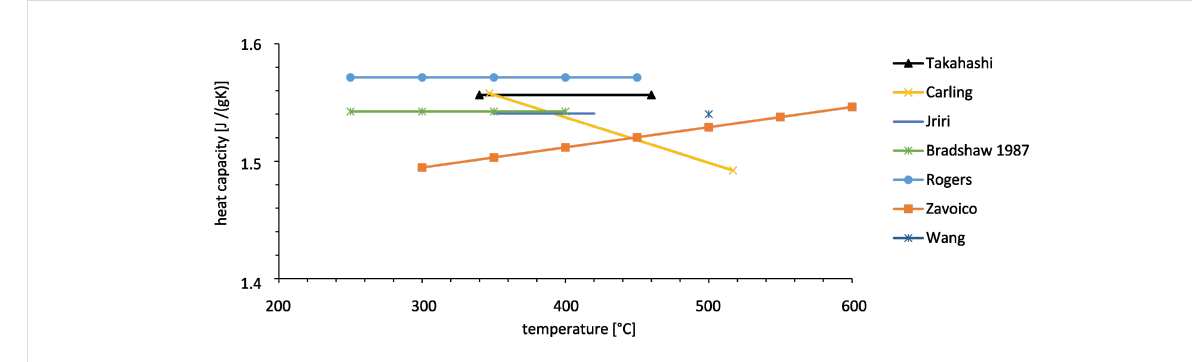
Figure 2: Heat capacity of Solar Salt in the liquid phase [3-9].